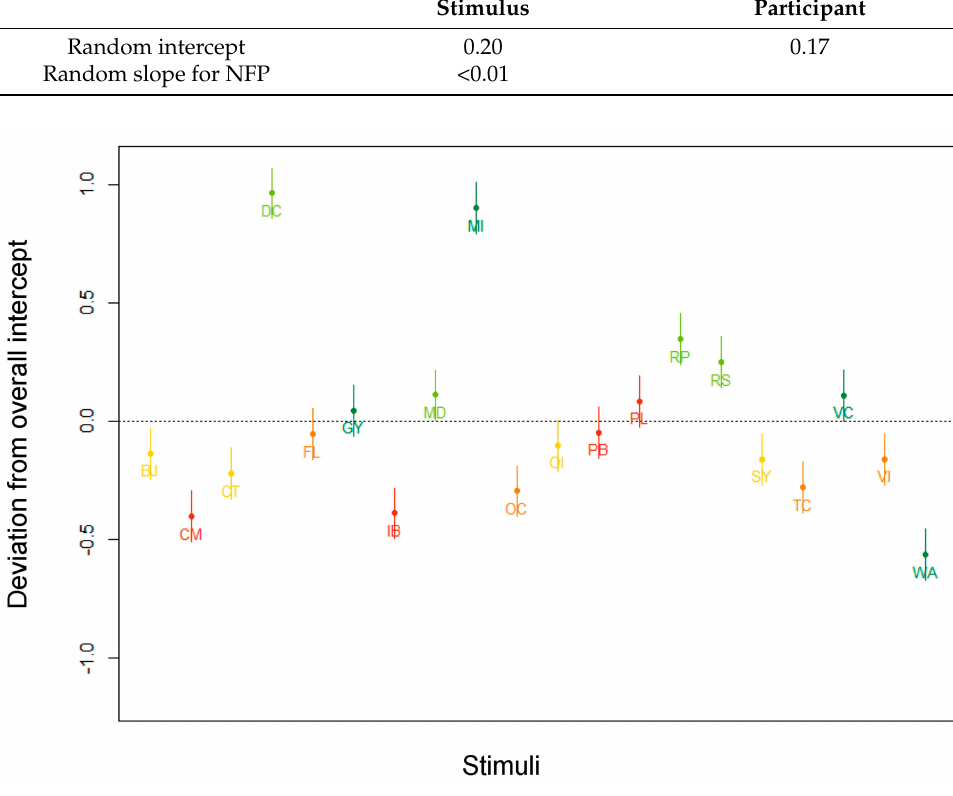
Figure 9. By-stimulus random intercepts in the subset of participants exposed to products with Nutri-Score. Abbreviations of the product names are explained in Figure 4 and in Appendix A (Table